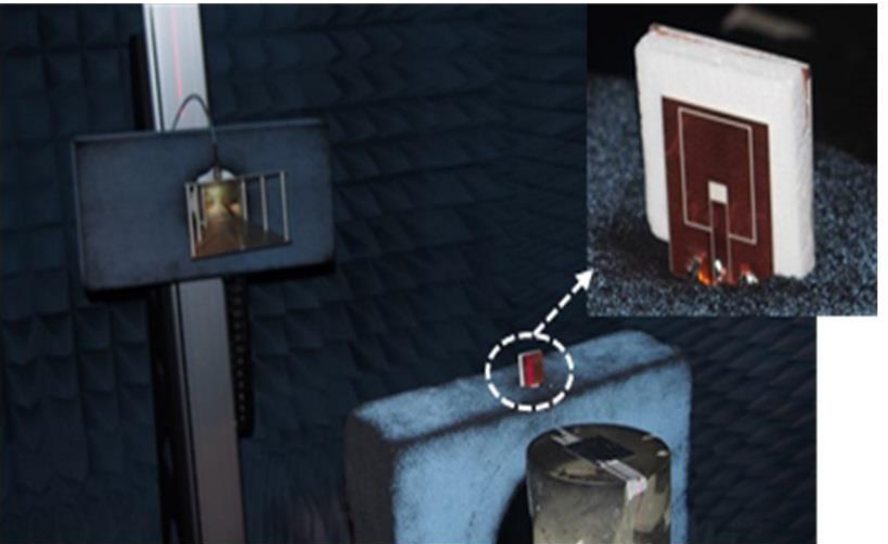
Figure 5. Prototype of the fabricated CPW antenna above proposed MD-AMC substrate in an anechoic chamber.